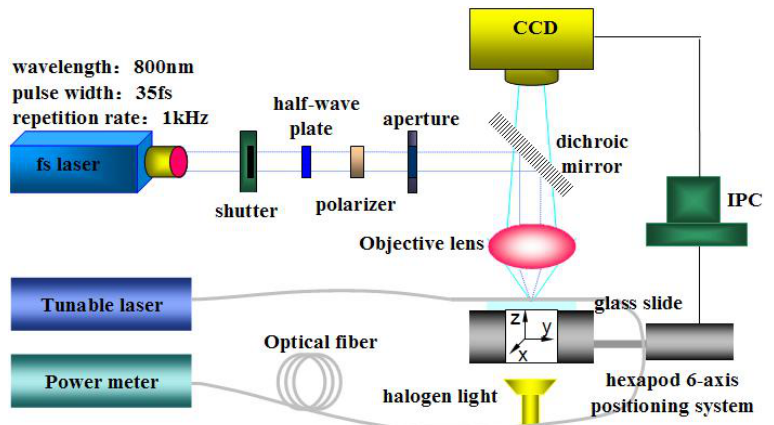
Figure 1. The scheme of the fs laser fabrication